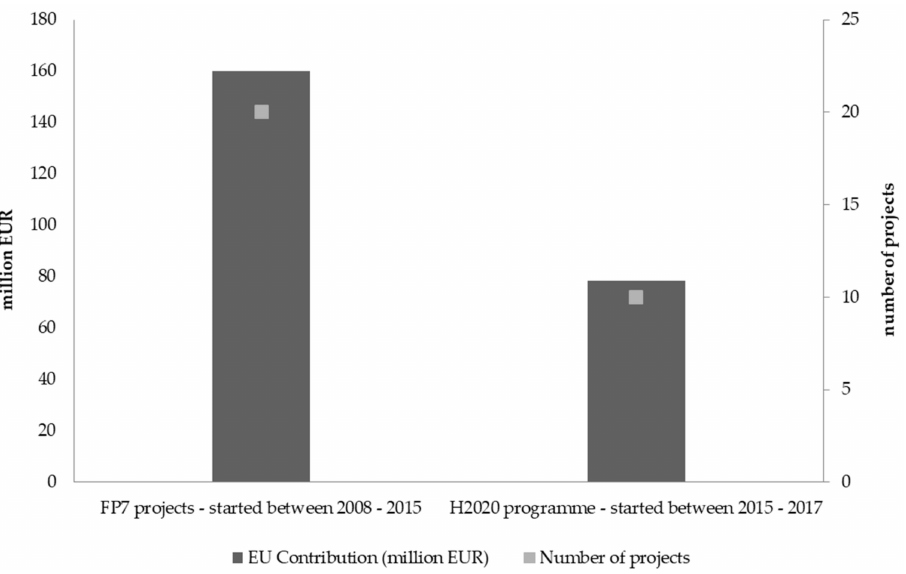
Figure 3. Numbers of Seventh Framework Programme (FP7) and Horizon 2020 program (H2020) projects and total amount of EU funding (million EUR) identified for cellulosic ethanol.